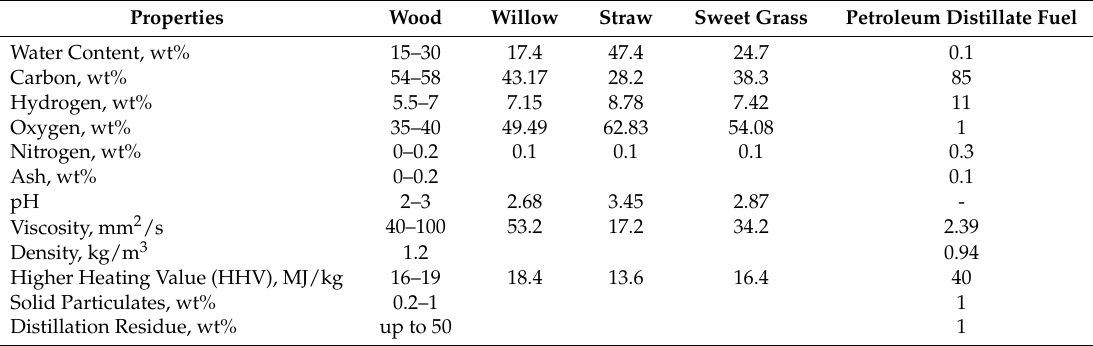
Table 6. Comparison of the properties of pyrolysis bio-oil produced by various lignocellulosic feedstocks and common distillate fuels. Data taken from